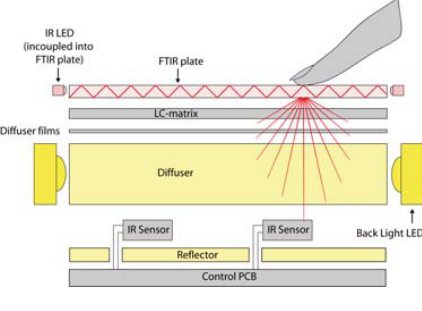
Figure 7. IR-sensors in the LC-screen